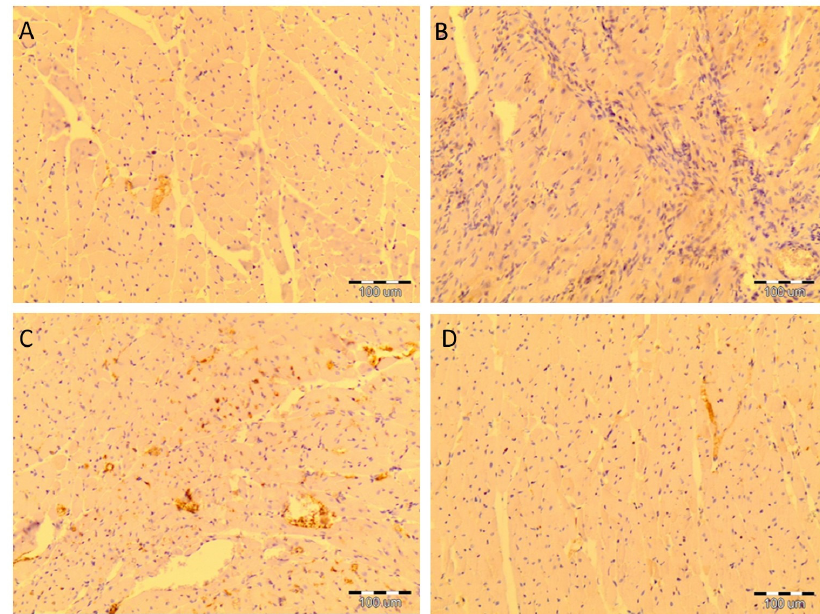
Figure 8. Resveratrol increased Bcl-2 expression in heart tissue of the essential and malignant hypertensive rats. The expression of Bcl-2 in heart tissue was examined by immunohistochemical staining, magnification 400×, positive reaction— yellow color. ( A ) The SHR group showed rare immuno-positive cells, ( B ) negative immunostaining in the MHR, ( C ) intense cytoplasmic staining of Bcl-2 in SHR + R group (yellow), and ( D ) the MHR + R group showed rare immuno-positive cells.